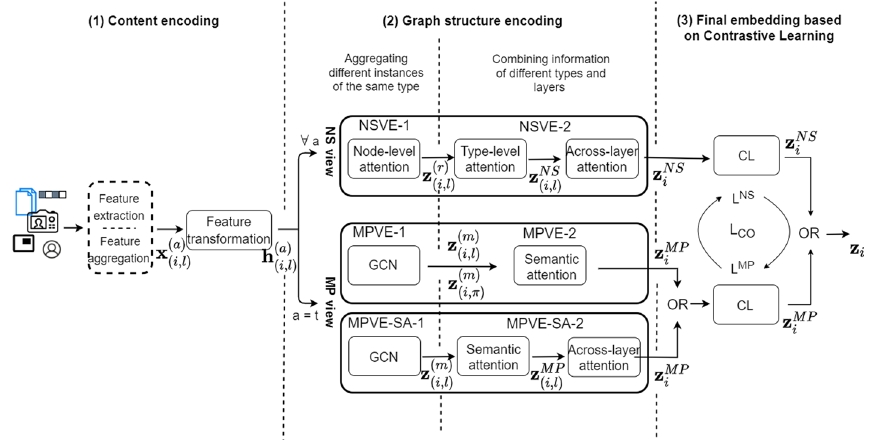
Fig. 2 Illustration of the three stages of the proposed Co-MLHAN